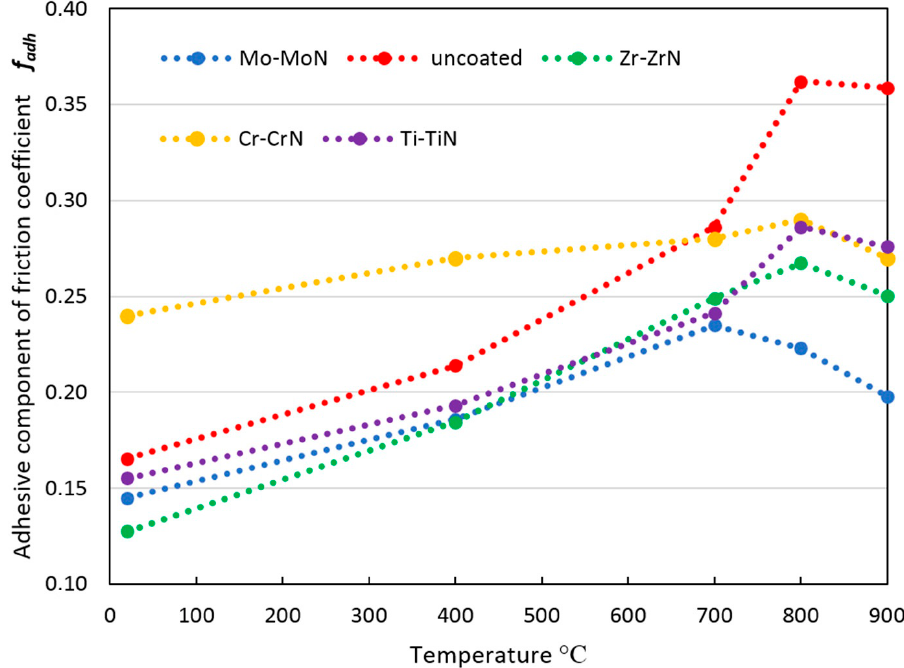
Figure 5. Relationship between the adhesive component of friction coefficient f adh and the tempera- ture for the uncoated samples and the samples with the Ti-TiN, Zr-ZrN, Cr-CrN, Mo-MoN coatings. To determine the corrosion current density of the studied samples in the 3 wt.% aque- ous NaCl solution at the temperature of 25 ◦ C, the mathematical modeling of the corrosion process was applied by iterations based on the experimental data and by using Tafel’s extrapolation of the anodic and cathodic polarization curves using the Nova 2.0 software (Table 4 and Figure 7). Table 4. Results of mathematical modeling of the corrosion process on the samples made of Ti-6Al-4V alloy with different coatings in the 3 wt.% aqueous solution of NaCl at the temperature of 25 ◦ C, by the method of iterations based on experimental data